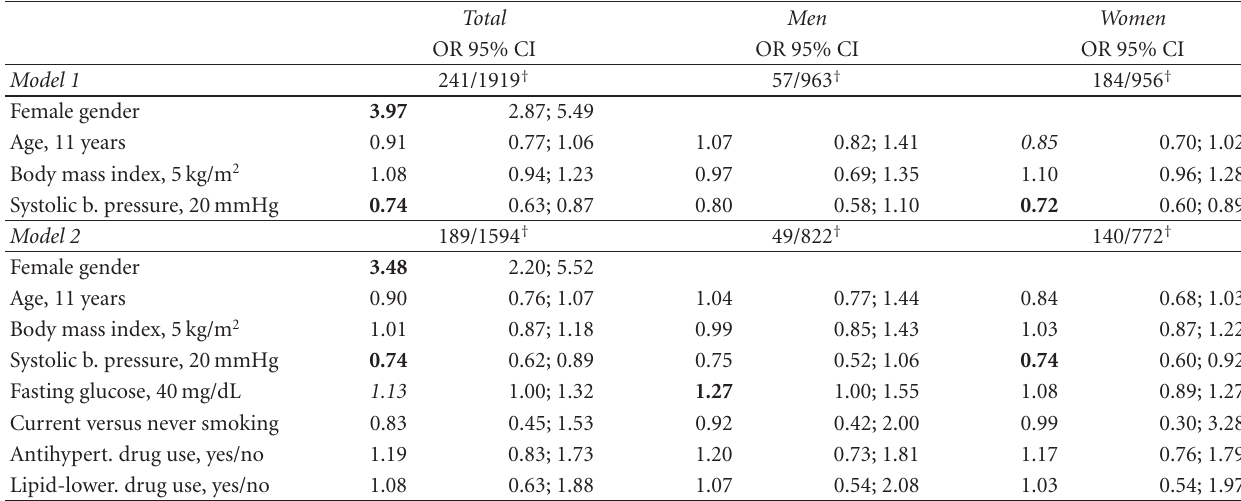
Table 2: Logistic regression analysis for the association of certain parameters with depressive disorder, by